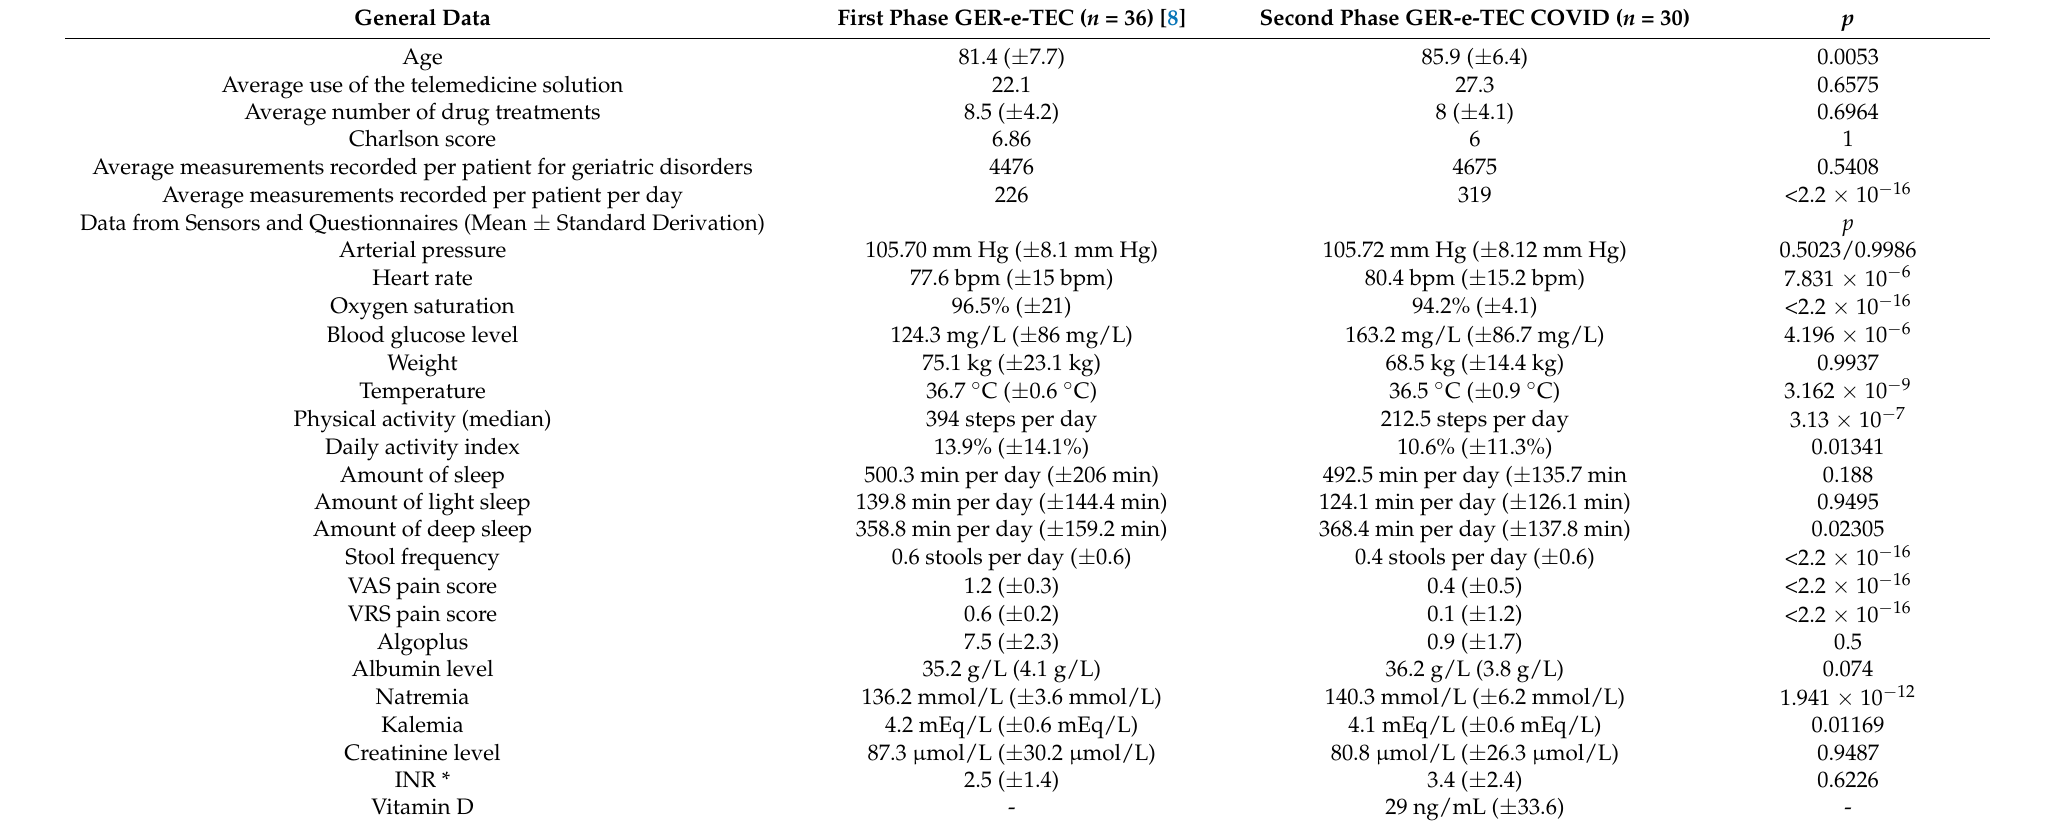
Table 3. General and collected data from sensors and questionnaires during the two phases of the Ger-e-Tec